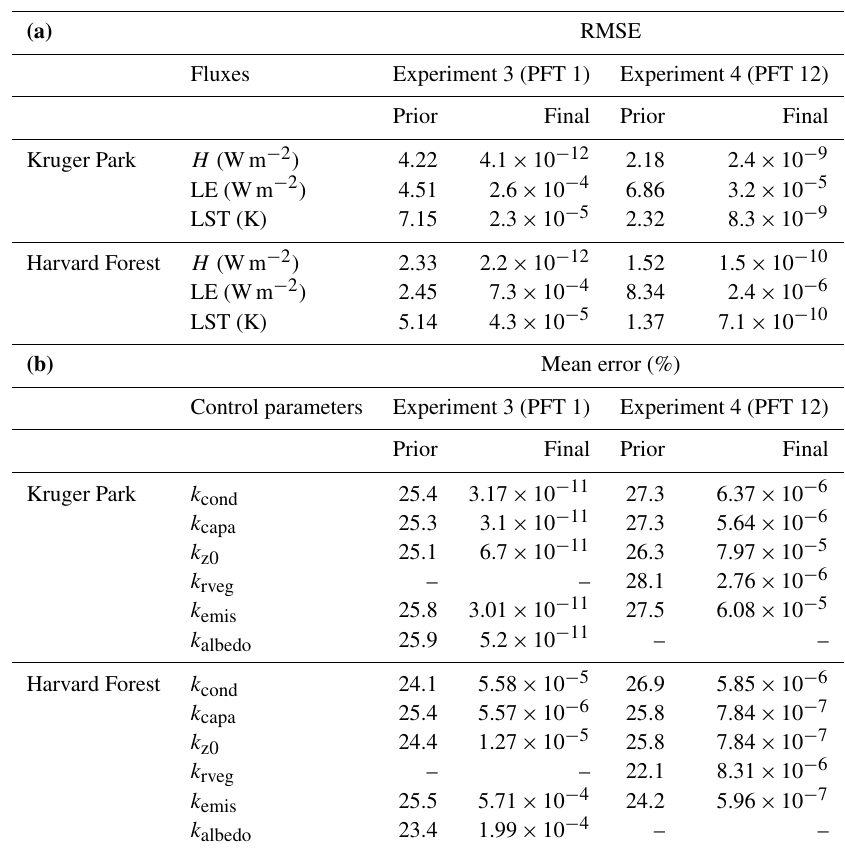
Table 8. Results for Experiments 3 (PFT 1) and 4 (PFT 12). RMSE of model fluxes (a) and parameter relative errors (b) before and after the assimilation process on FLUXNET Harvard Forest and Kruger